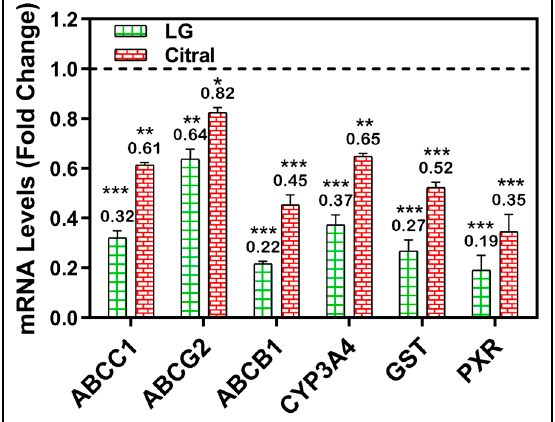
Figure 5. RT-PCR of CYP3A4, GST, PXR, ABCC1, ABCG2, and ABCB1 genes in HepG-2/ADR cells after 24 h of LG, citral therapy. ( n = 3) Mean ± S.D. * ( p < 0.05). ** ( p < 0.01), *** ( p < 0.001). The data are presented as the mean ± SD of the fold-change related to untreated control and normalized to the β 2mg housekeeping gene.